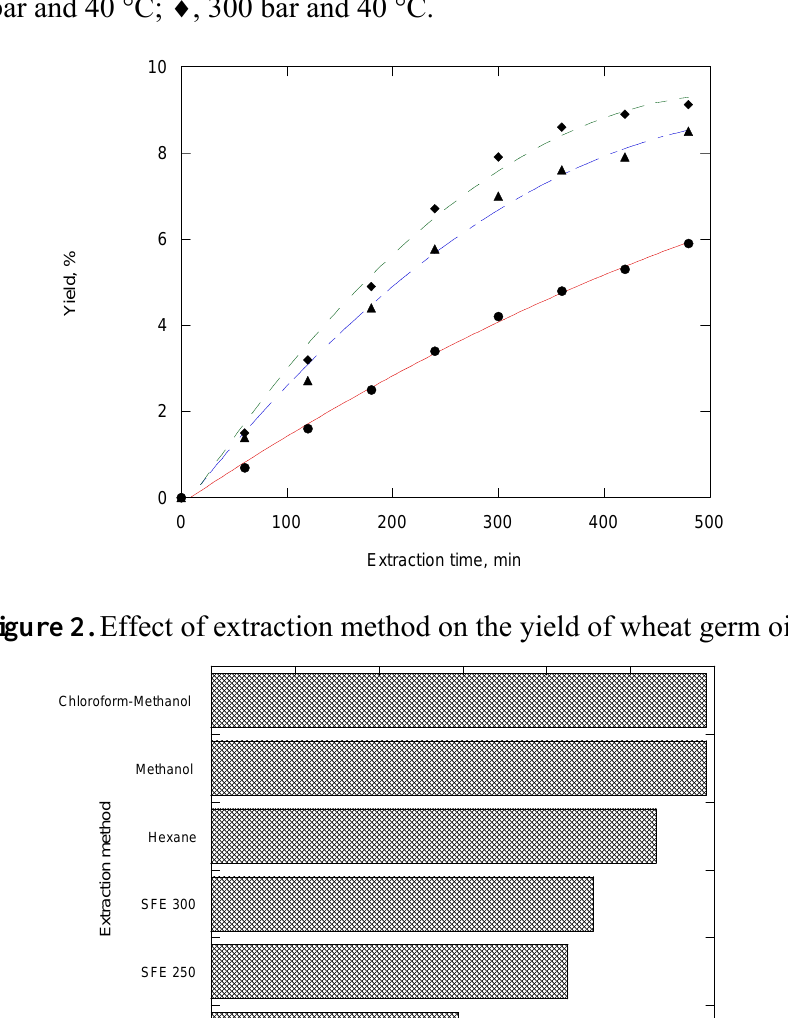
Figure 1. Effect of pressure on the extraction yield of wheat germ oil:  , 200 bar and 40 °C; ▲ , 250 bar and 40 °C;  , 300 bar and 40 °C.